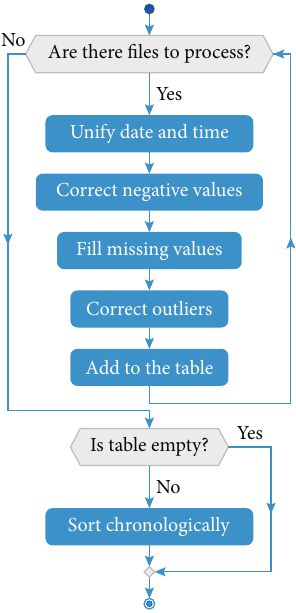
Figure 4: Data preprocessing